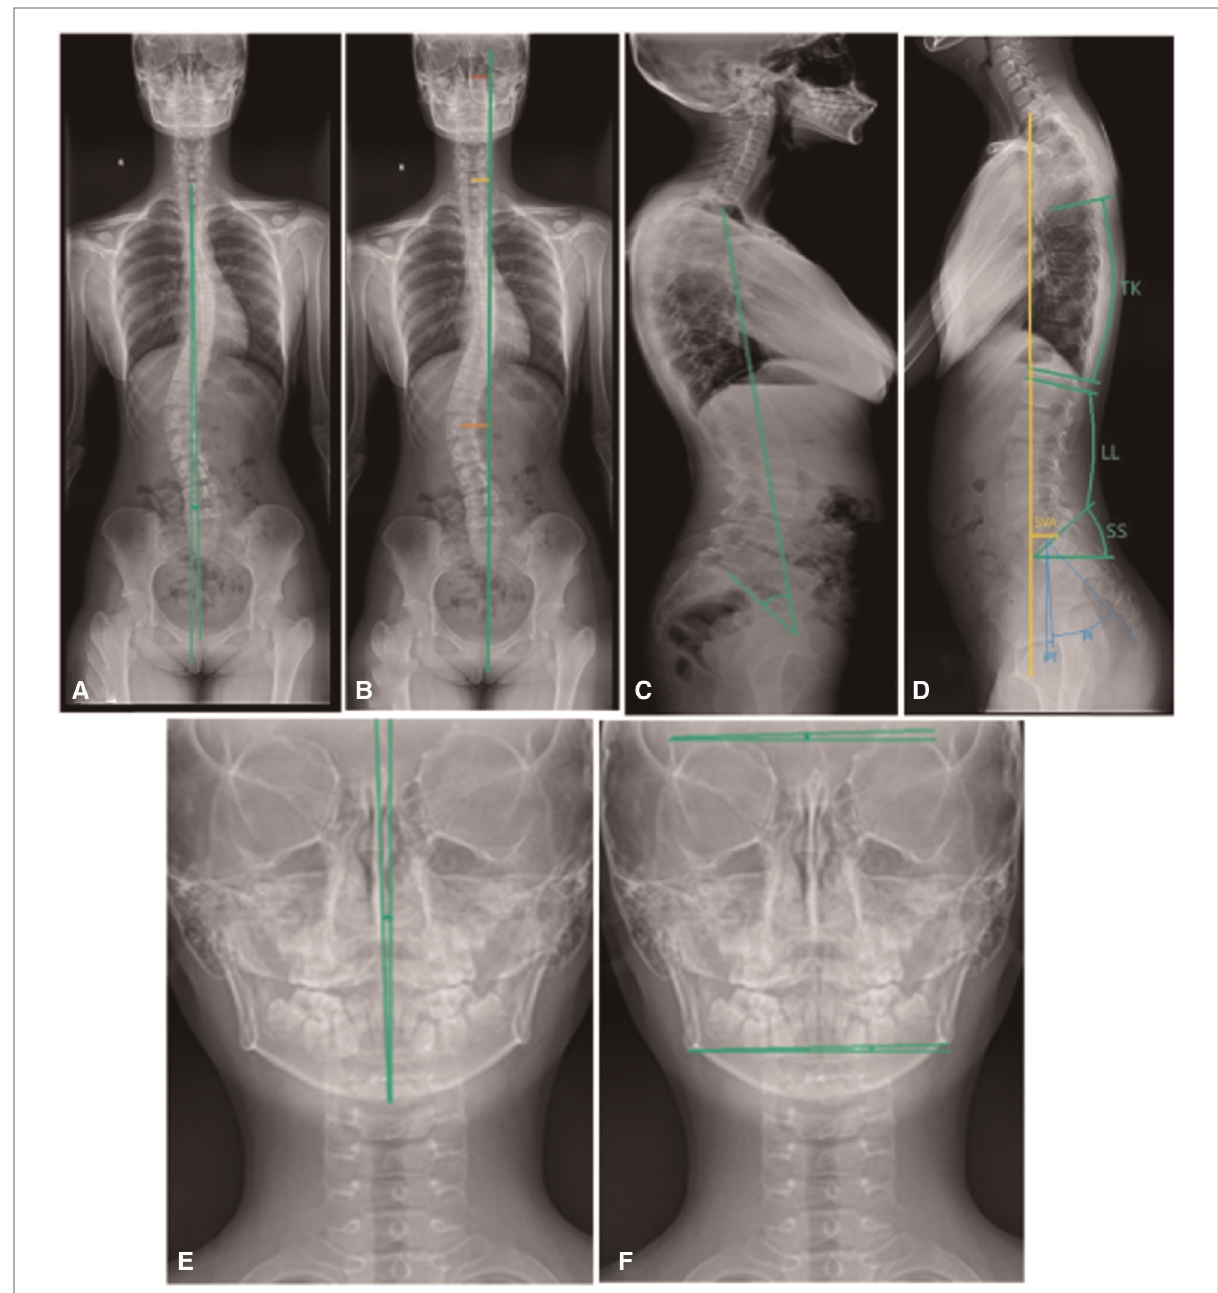
FIGURE 1 Demonstration of the measurement of spinal parameters. ( A,B ) Trunk azix line angle (TALA), trunk deviation distance (C7-CSVL), Apical vertebral translocation (AVT), head offset distance. ( C ) TPA (Trunk pelvic angle). ( D ) Thoracic kyphosis (TK), lumbar lordosis (LL), sacral slope (SS), pelvic tilt (PT), pelvic incidence (PI), and sagittal vertical axis (SVA). ( E,F ) Head inclination angle (angle between the center line of the head and the gravity vertical line), eye inclination angle (the angle between the tangent line of bilateral superior orbital margin and the horizontal line), and mandibular inclination angle (the angle formed between bilateral mandibular angle and the horizontal